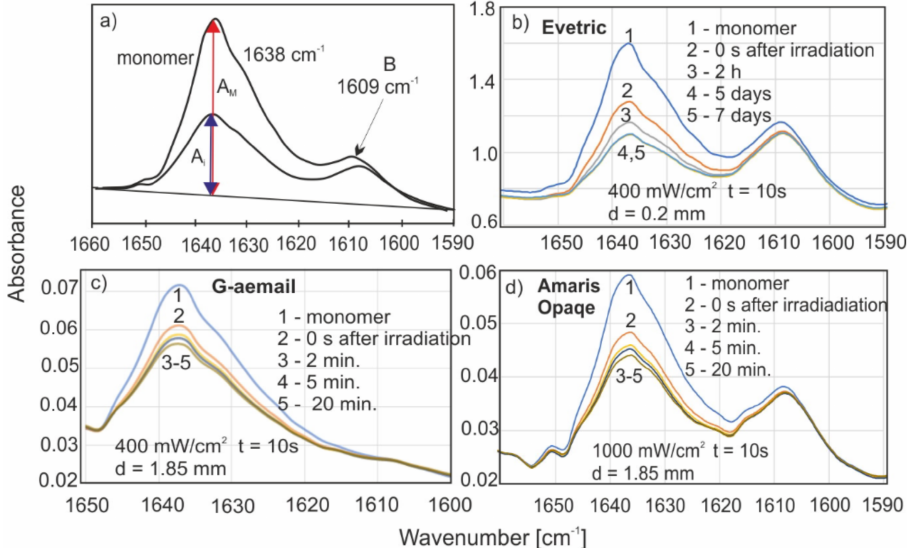
Figure 2. ( a ) The method of determining the value of the absorbance of the bands by taking into account the baseline, ( b ) an example of the change of the absorption spectrum in the transmission mode, ( c , d ) examples of the changes of the absorption spectra in the reflectance mode (ATR).